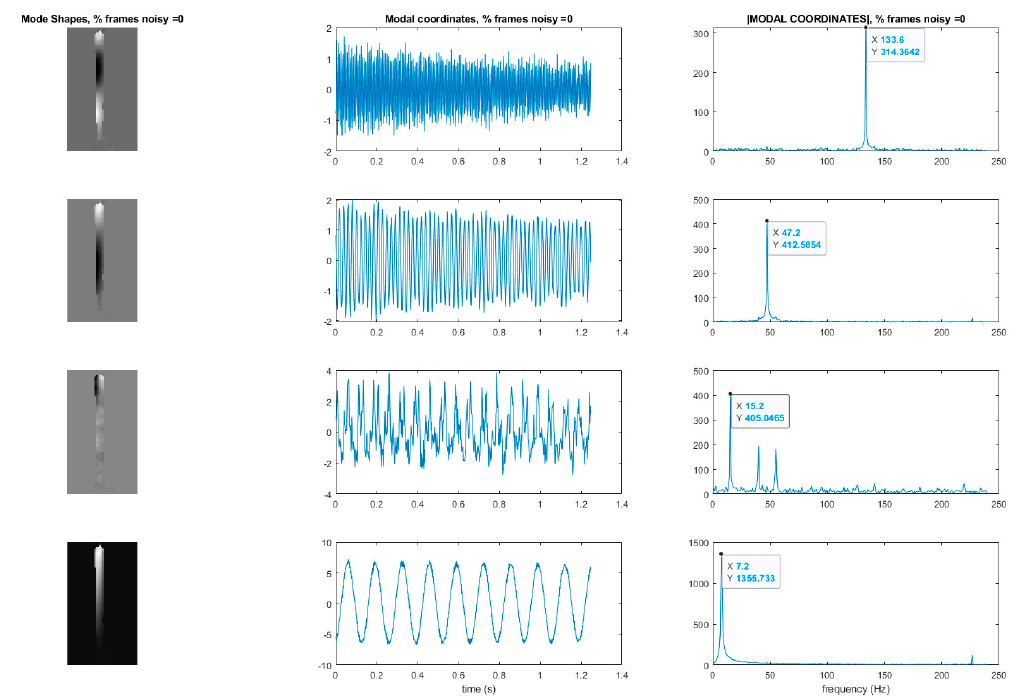
Figure 10. Mode shapes and modal coordinates of the cantilever beam recovered from the original video. Y -axis of the modal coordinate and the magnitude of the fft(modal coordinate) plots are arbitrarily scaled displacement.